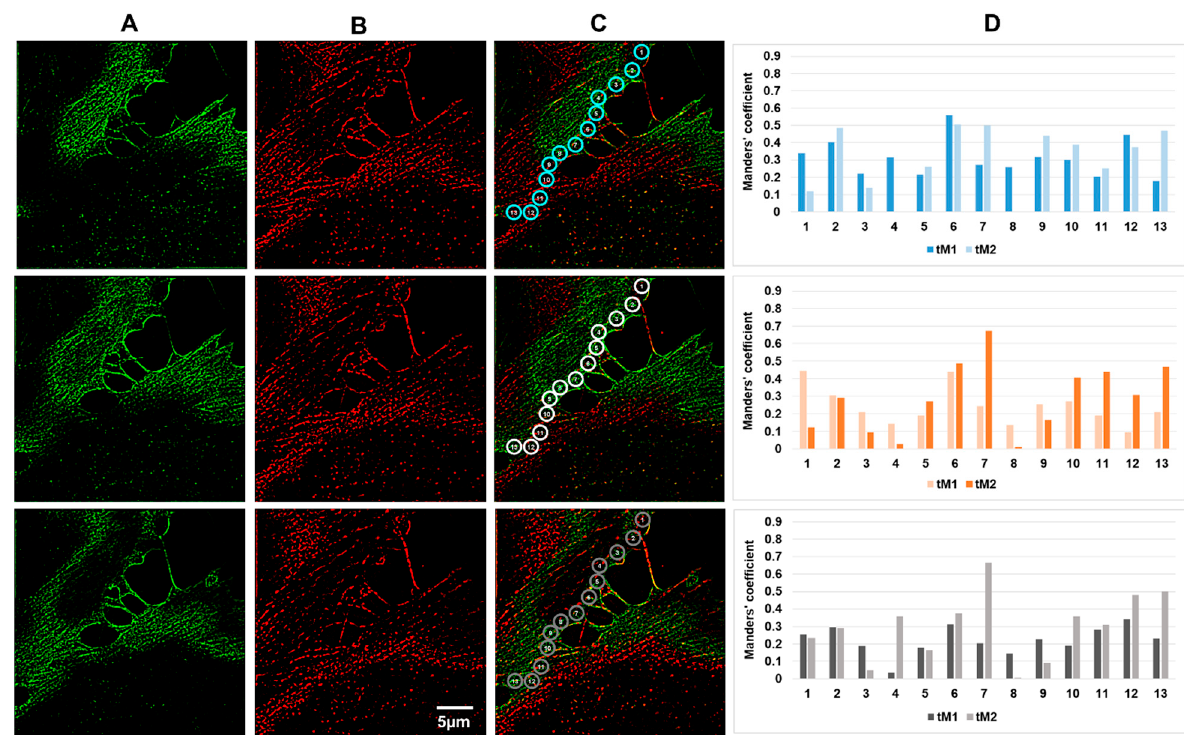
Figure 6. Analysis of colocalization of actin filaments in the marginal regions of EA.hy926 cell after 0.01 μ M nocodazole treatment. Vertical panel ( A ), immunofluorescent staining of β -actin; vertical panel ( B ), immunofluorescent staining of γ -actin; vertical panel ( C ), merged, vertical panel ( D ), three series of fluorescence intensity measurements in successive optical sections in the ROI defined by circles (marked in blue, white and grey) at the cell edge. Measurements of the tM1 and tM2 threshold Manders’ coefficient in three adjacent optical sections are presented. Occasionally, in the adjacent sections for a given ROI, the Manders’ coefficients varied significantly.